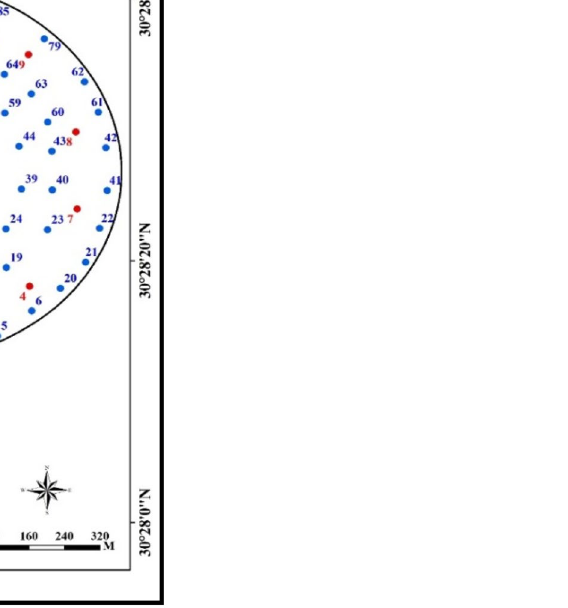
Figure 3. Soil profiles and grid systems of the study